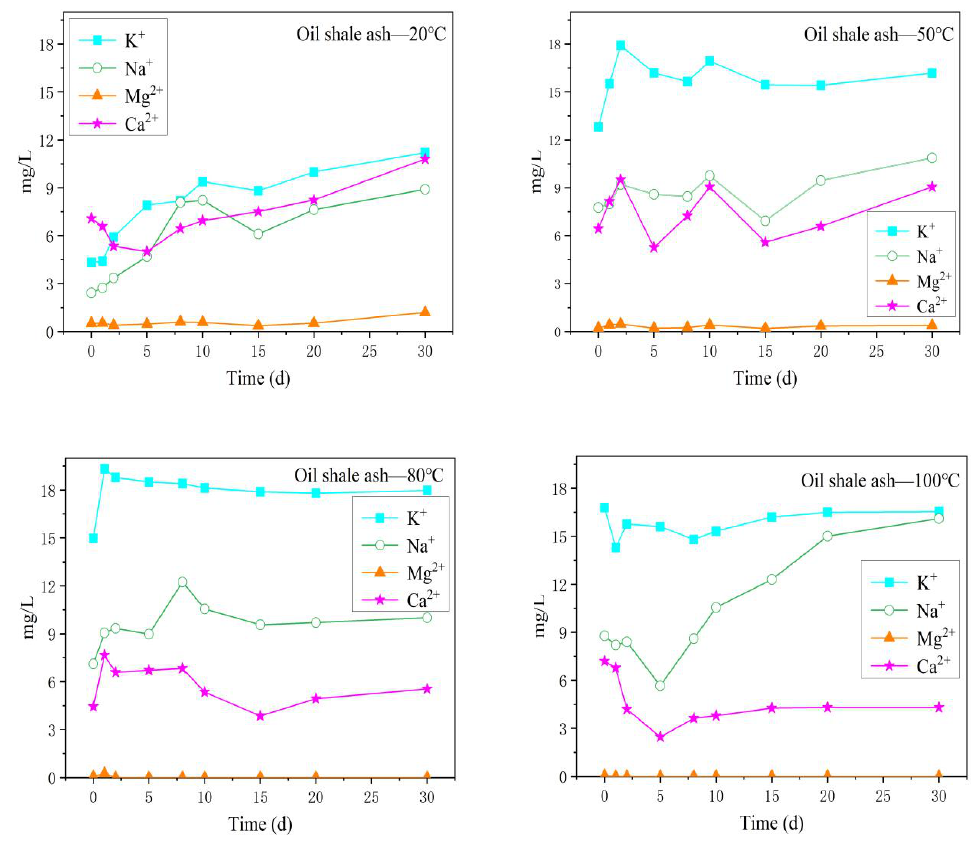
Figure 5. Variation in the content of the main cations in the oil shale–ash aqueous solution under different temperature reaction conditions. The variation in the content of the main cations in the surrounding rock aqueous solution with different reaction temperatures is shown in Figure 6. With increasing reac- tion time, the content of cations showed an upwards trend. Under the reaction conditions of 20 °C and 50 °C, the content of Ca 2+ in the aqueous solution was the highest, followed by Na + and K + , and Mg 2+ was the lowest. The content of Na + was the highest at 80 °C and 100 °C, followed by Ca 2+ , K + , and Mg 2+ . With increasing reaction time, the cationic content in the aqueous solution increased steadily under the reaction condition of 80 °C, but fluc- tuated greatly under the reaction condition of 100 °C.